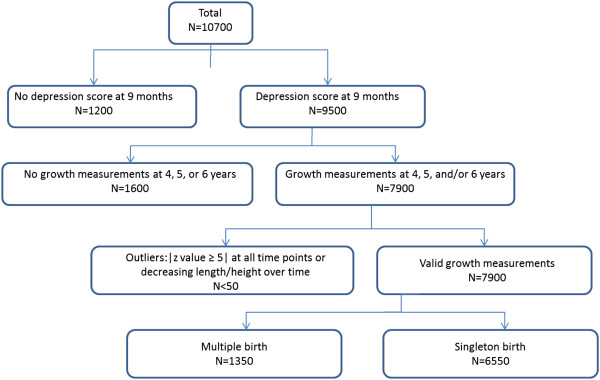
Exclusion criteria on left side of flowchart and inclusion criteria on right side, leading to selection of study participants (N = 6550).